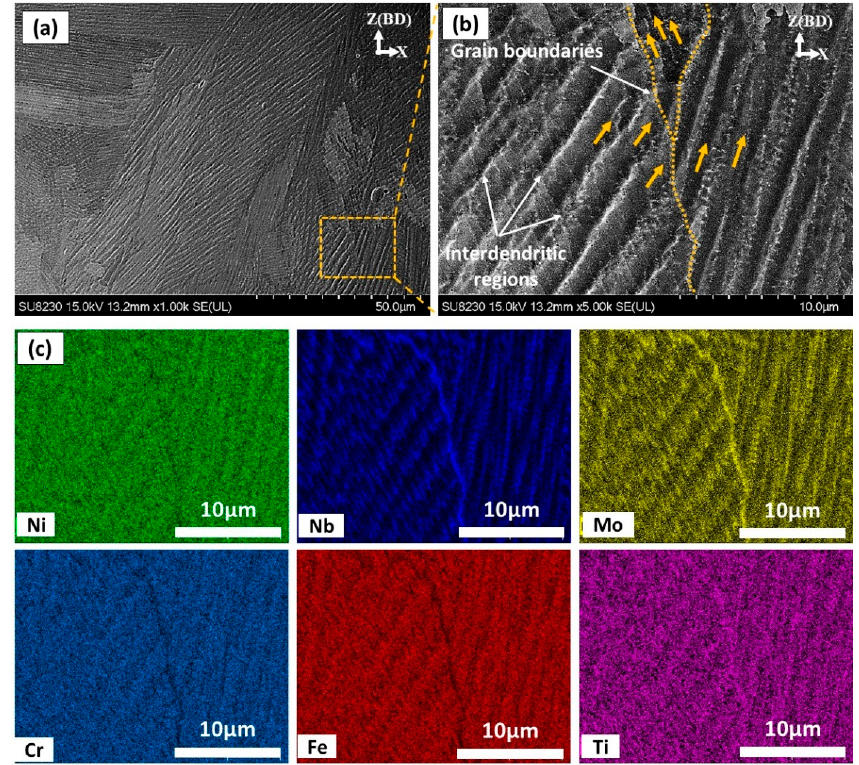
Figure 7. ( a , b ) SEM micrograph of the as-printed condition illustrating the segregates in the inter-dendritic and grain boundary regions; ( c ) EDS elemental distribution in the areas indicated in ( b ). Materials 2020 , 13 , x FOR PEER REVIEW